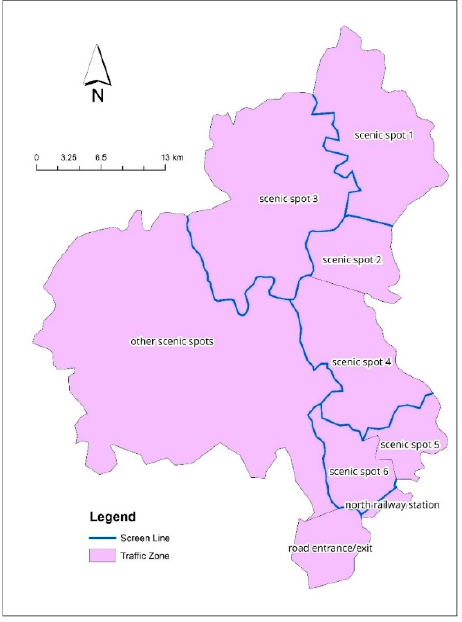
Figure 10. Spatial distribution of the screenlines.